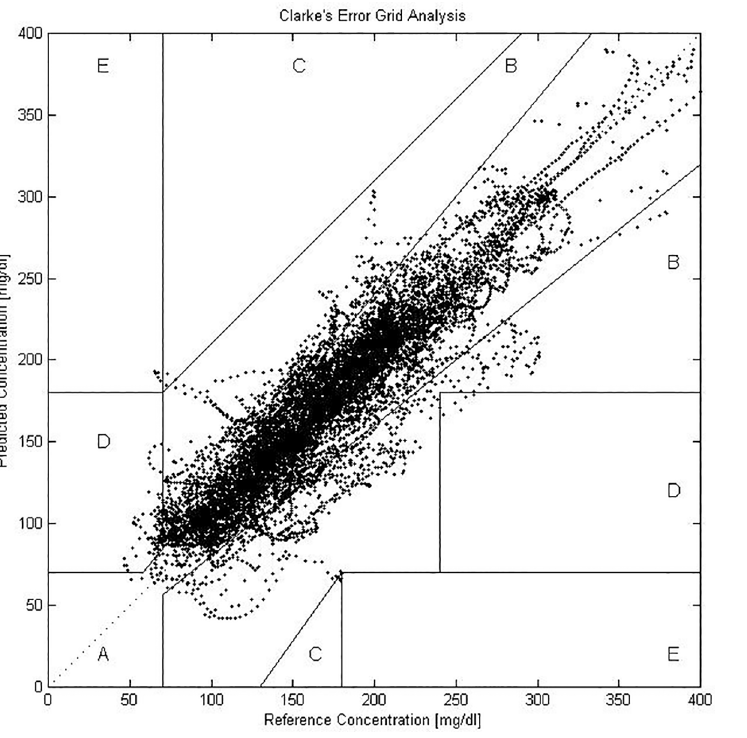
Fig 3. Clarke error grid for test data of 20 patients in the breakfastperiod.